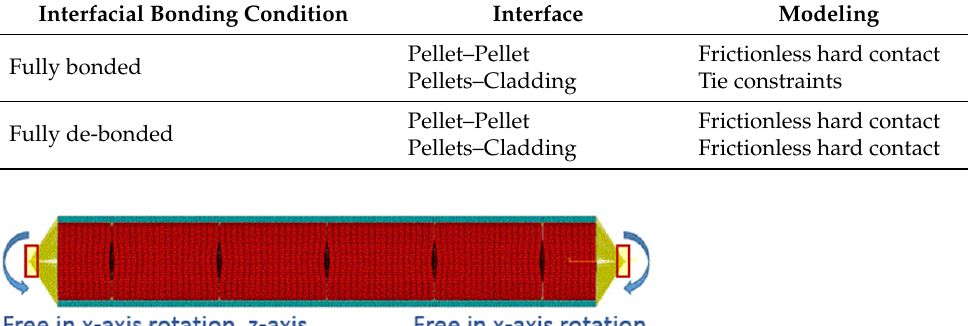
Figure 6. Mesh density of the cladding. Table 3. Interfacial bonding condition modeling of the fully bonded and de-bonded conditions.